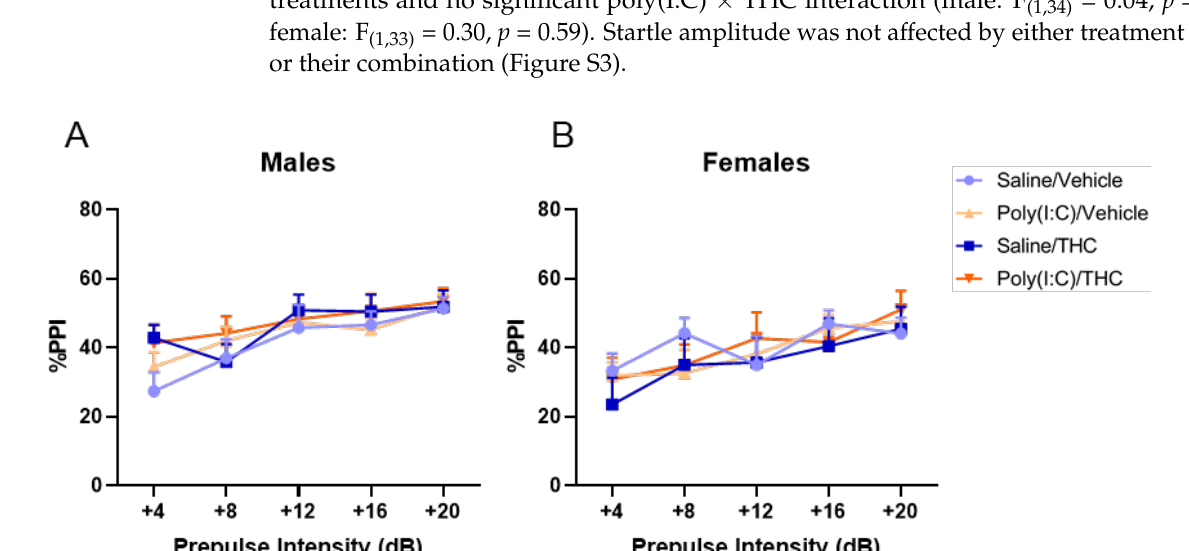
Figure 3. Prepulse inhibition (PPI) of the acoustic startle reflex in male ( A ) and female ( B ) adult offspring. The average percent PPI at five prepulse intensities was calculated. There were no effects of poly(I:C) or THC on PPI. All values are the mean ± SEM. n = 8–10 mice/sex/treatment.